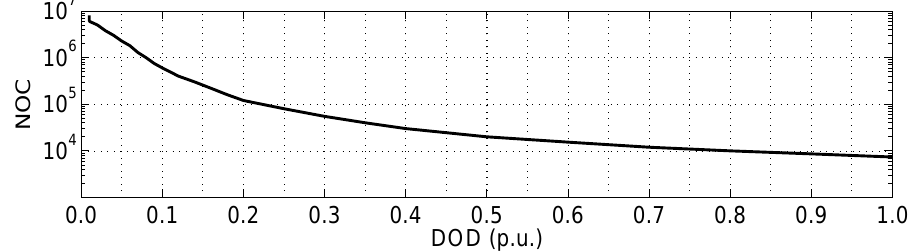
Figure 17. Number of cycles (NOC) vs . depth of discharge (DOD) of the selected